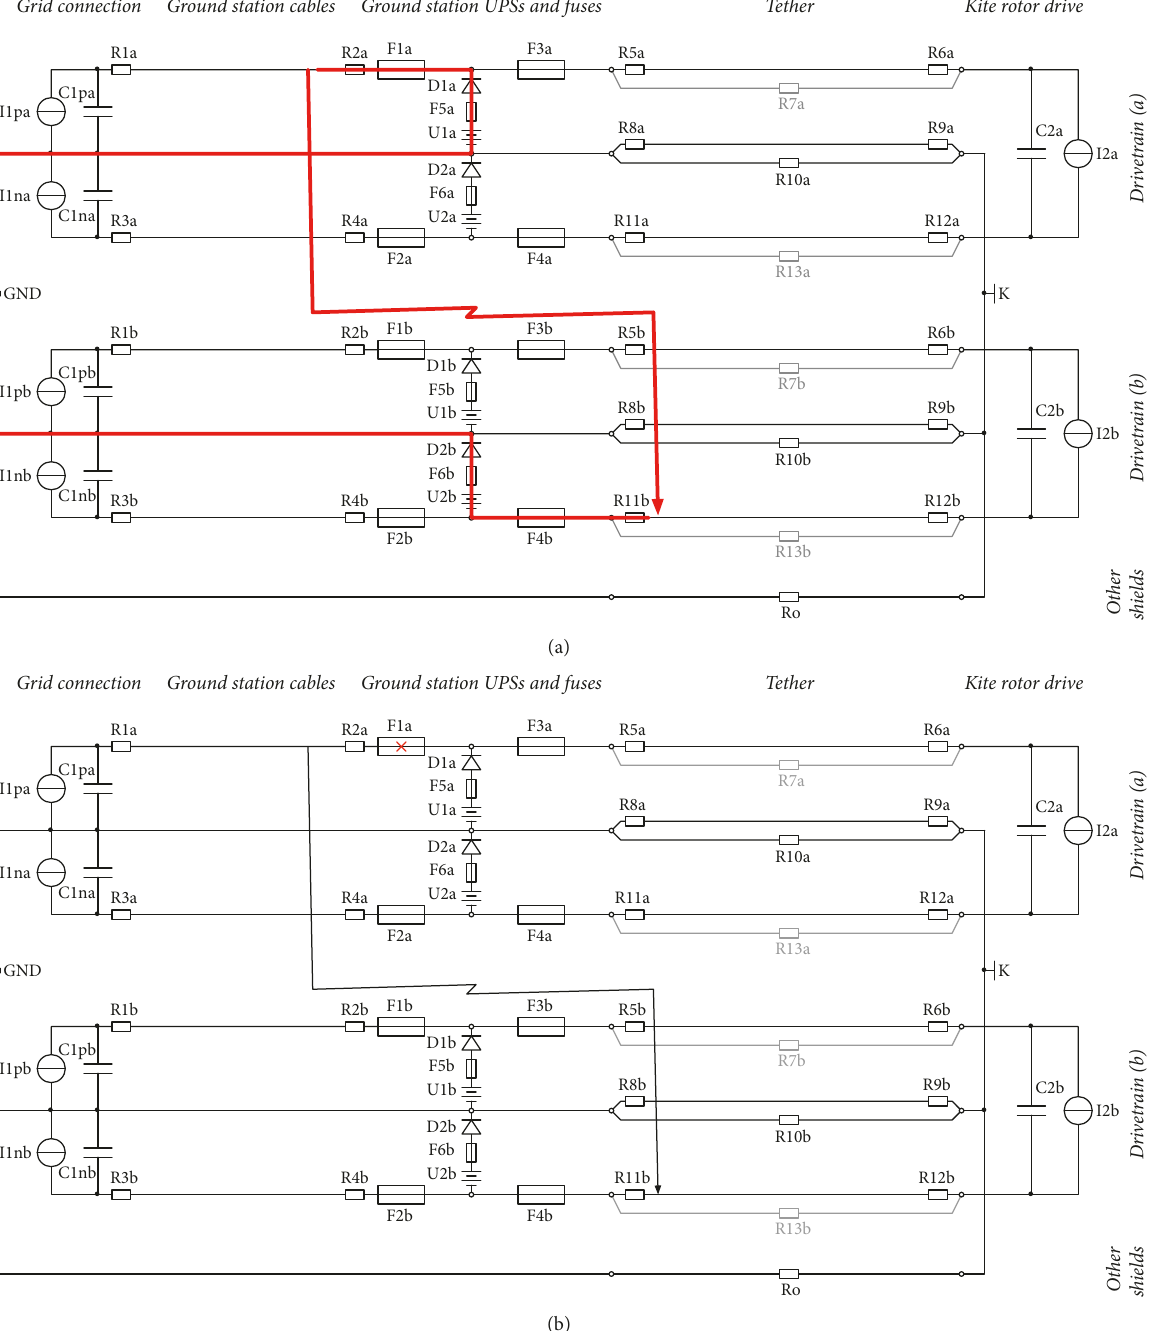
Figure 22: Investigation of short circuit fault S21: (a) short circuit currents driven by UPS(s) and (b) circuit after fuse